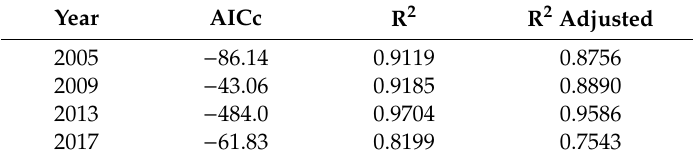
Figure 10. Net relatedness index (NRI) geographic weighted regression standardized residuals. Table 4. Net relatedness index (NRI) geographic weighted regression fitting parameters.